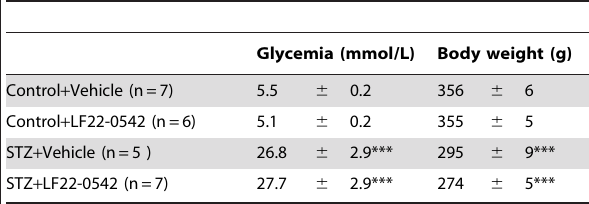
Table 2. Effect of diabetes and LF22-0542 on glycemia and body weight.